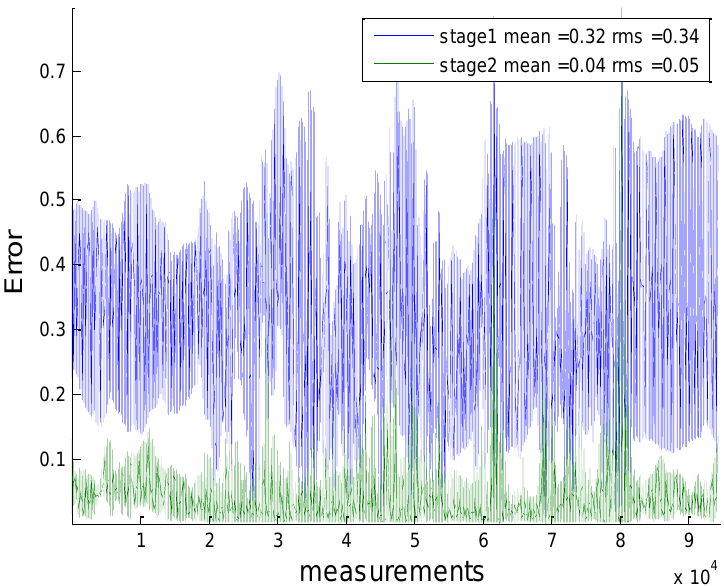
Figure 10. Normalized errors for two stages of the calibration